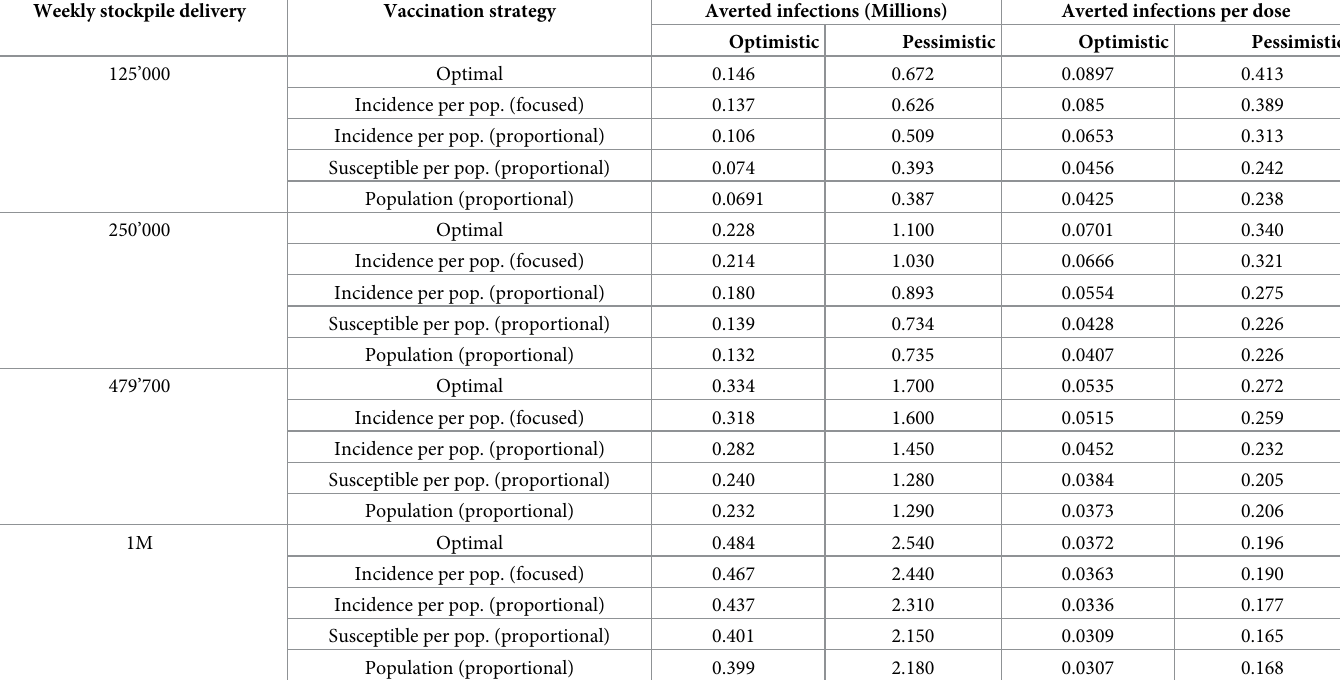
Table 1. Absolute number of averted infections (in millions) and averted infections per dose during the first three months of 2021 as evaluated for the reference tra- jectory (see Fig 2) for each strategy. The first column represents the considered scenarios of weekly stockpile replenishment, i.e., the number of doses delivered to Italy every week, ranging from 125’000 to one